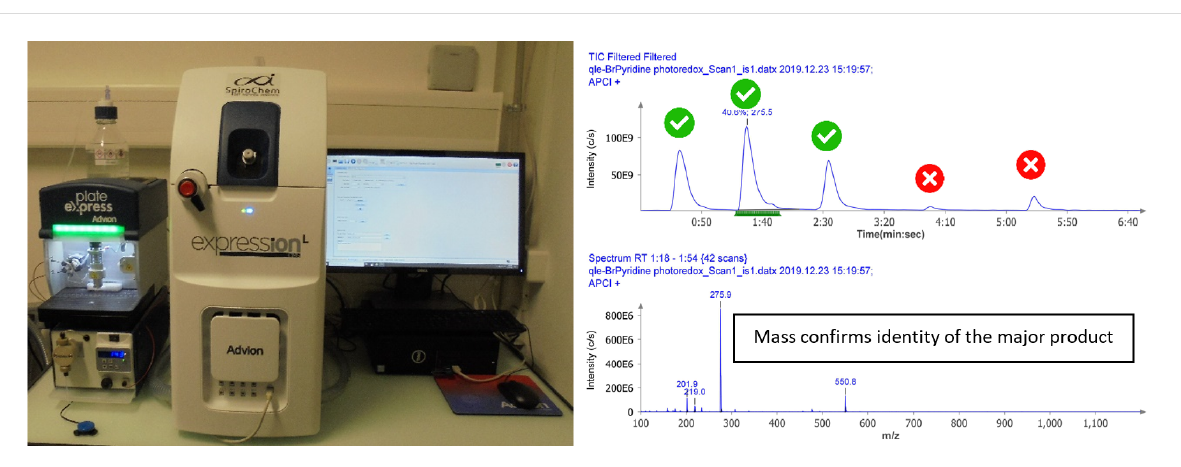
In 4 days of experimentation, 29 combinations of bicycloalkyl- amines or spirocyclic amines with (hetero)aryl bromides were probed using this workflow, and the results are depicted in